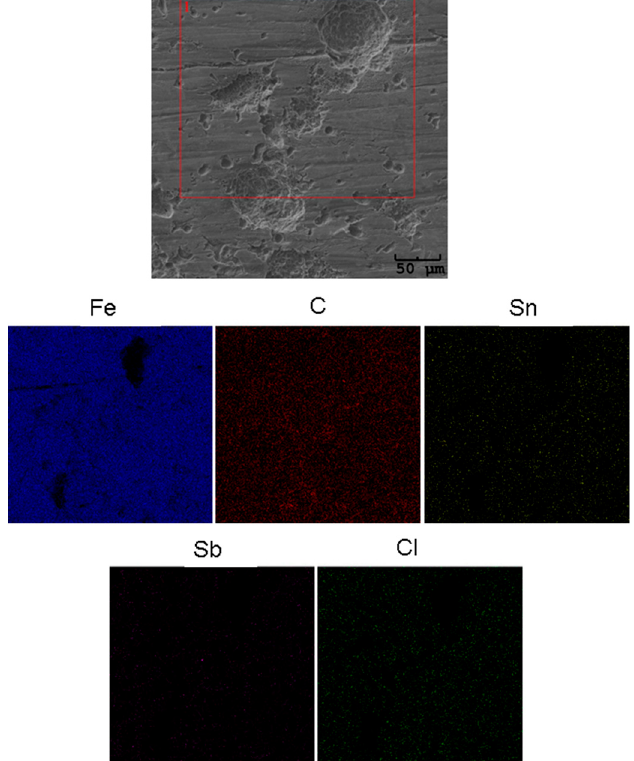
Figure 9. SEM image of the AISI 1010 carbon steel surface after the experiment in sulfolane at 95 ° C and etchig, and then the potentiodynamic test: on-top general view of the material with a selected micro-region, and with the corresponding EDS map of Fe, C, Sn, Sb, and Cl element distribution.